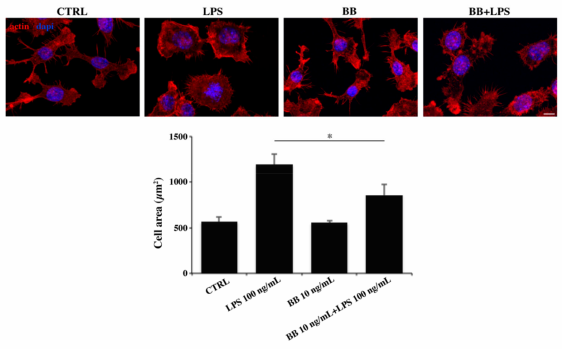
Figure 3. Analysis of cell morphology by rhodamine-conjugated phalloidin (TRITC-phalloidin) staining to highlight actin and 4’,6-diamidino-2-phenylindole (DAPI) to detect nucleus, after treatment with 10 ng / mL BB in the absence or presence of 100 ng / mL LPS. Bar: 20 µ m. Cell areas were quantified using Image J software. * p < 0.05 compared to